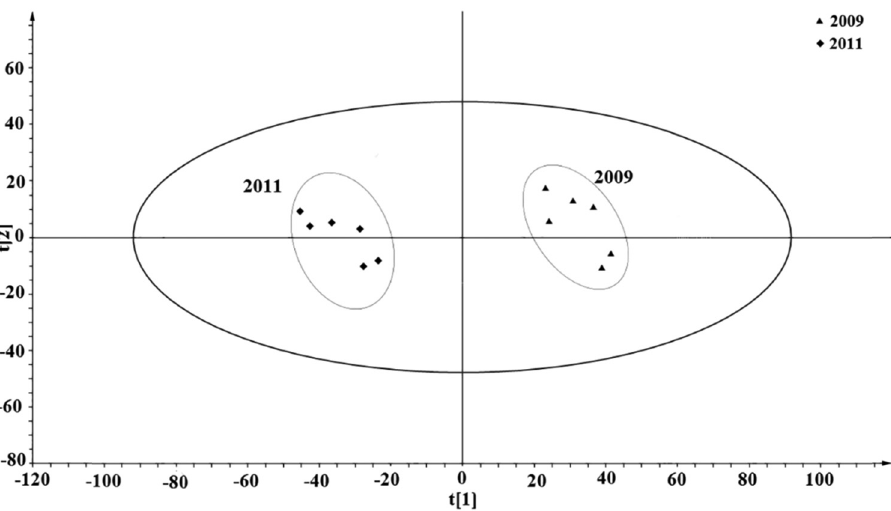
Figure 6: PLS - DA score plot chart from 1 H NMR spectra of 2009 and 2011 vintage Cabernet Sauvignon wines.